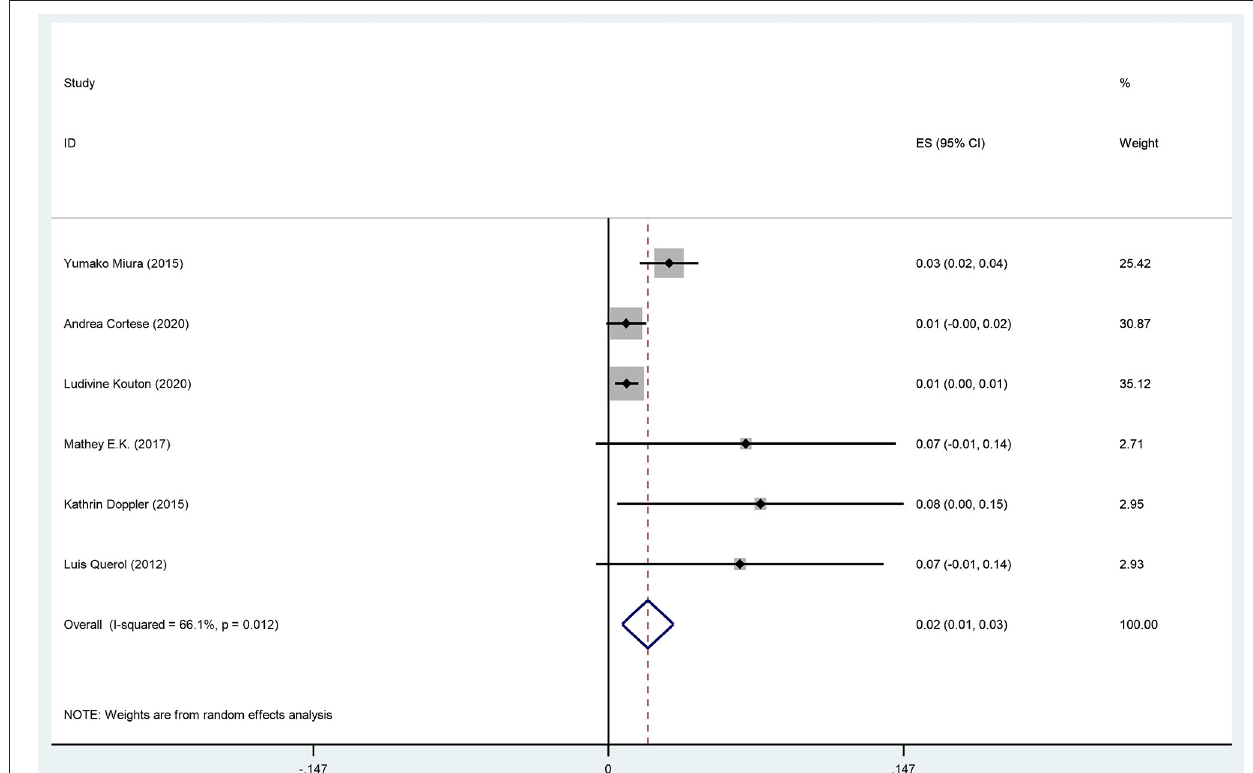
FIGURE 4 | The forest plot of the frequency of anti-CNTN1 autoantibody across 6 studies.